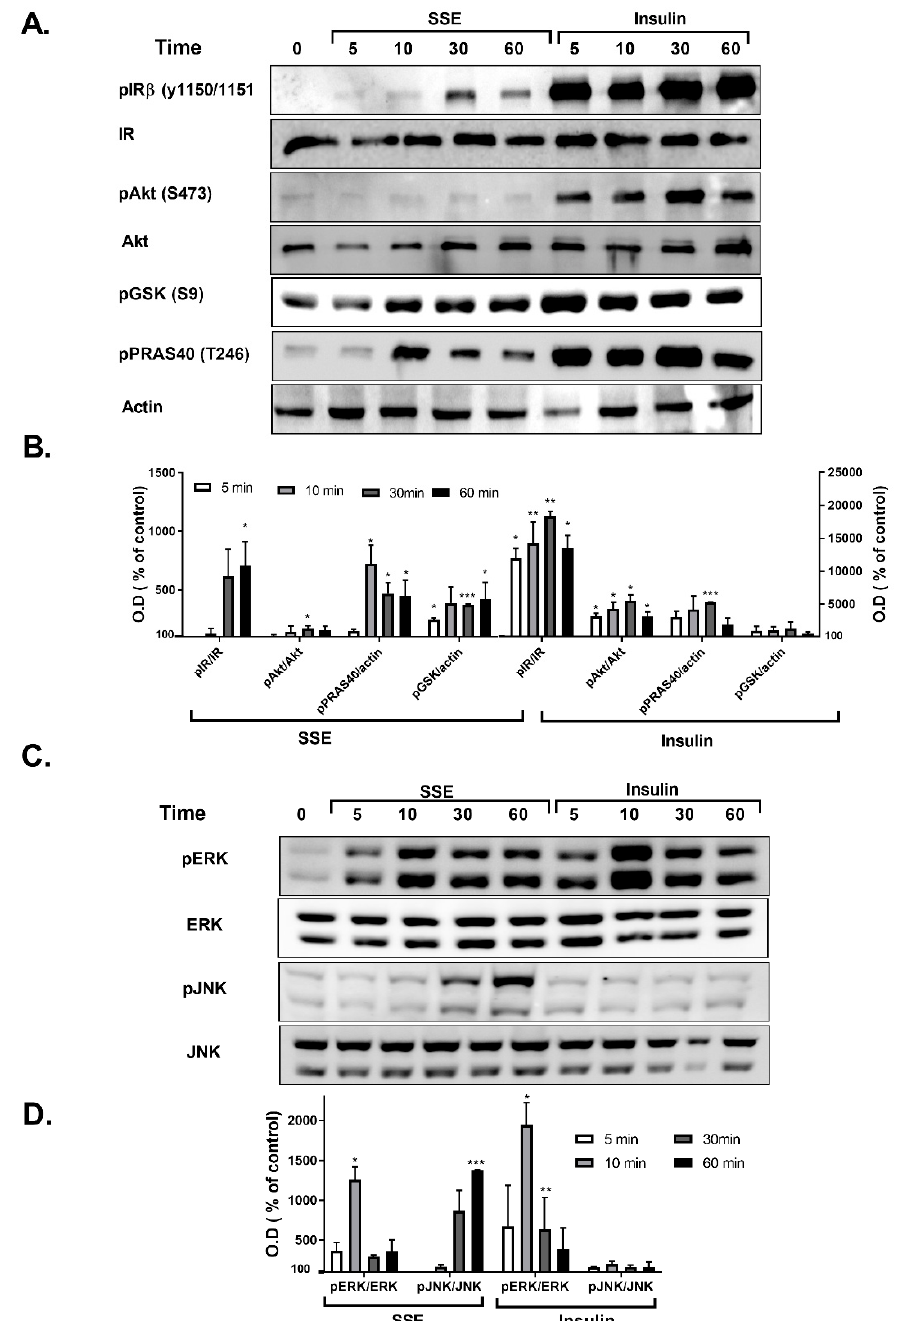
Figure 4. SSE phosphorylates components of the PI3K-Akt and MAPK pathway in 3T3-L1 adipocytes. 3T3-L1 adipocytes were treated with insulin or SSE for the indicated time. ( A , B ). Western blot analysis of proteins involved in PI3K-Akt pathway and a graph of optical densitometry (OD) measurements. ( C , D ). Western blot analysis of proteins involved in MAPK pathway and a graph of OD measurements. Phosphorylation level was normalized to the expression of the proteins. Results are presented as % of control. Each bar represents the mean ± SE of data obtained in three separate experiments. * p < 0.05, ** p < 0.005, and *** p < 0.0005 vs. control, analyzed by Student’s t